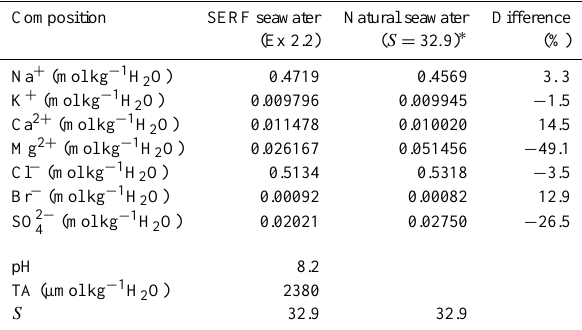
Table 1. Seawater composition used at SERF and in the FREZCHEM